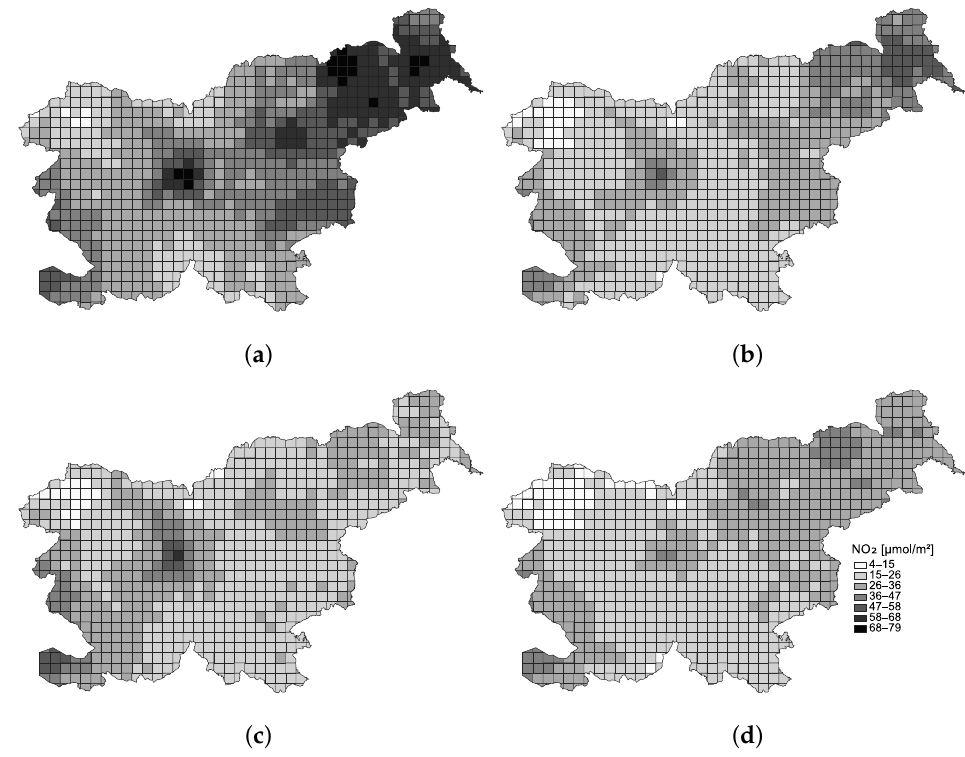
Figure 8. Samples of the satellite-like image, which were calculated by NN in the absence of the satellite data at different time moments: ( a ) UTC 5:00, on 16 March 2021; ( b ) UTC 9:00, on 20 April 2021; ( c ) UTC 17:00, on 24 May 2021; ( d ) UTC 22:00, on 1 June